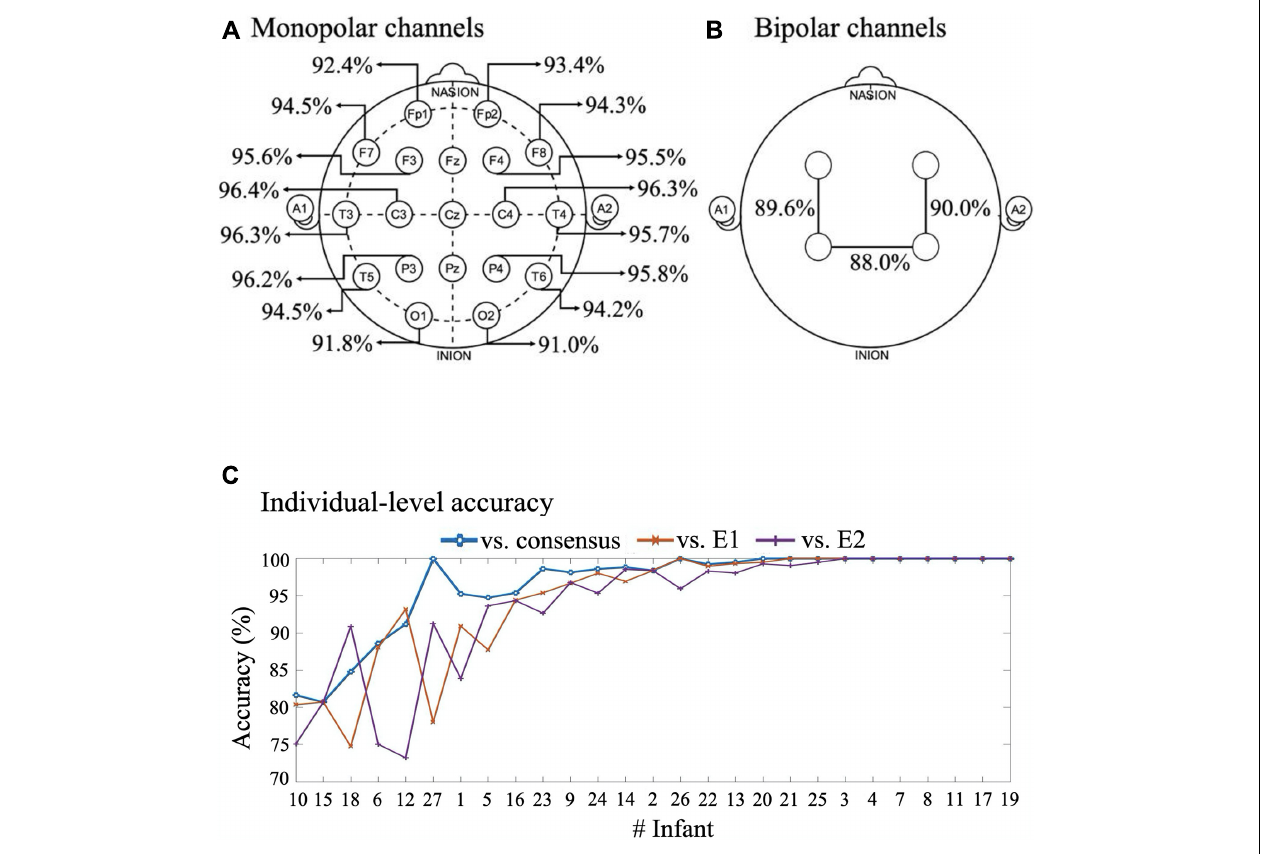
FIGURE 6 | Comparison of classifier accuracies in all channels and individuals. (A) 16 channels with monopolar montages. (B) Bipolar montages. Where in six infants with only 8-channel recording these montages are Fp1-C3, Fp2-C4 and C3-C3, and for 21 infants with 16-channel recording these montages are F3-P3, F4-P4, P3-P4. (C) Per infant classification accuracy vs consensus, E1 and E2 annotations. The infants are here ordered according to their mean classifier accuracy. All performance measures in this figure are given for the optimal